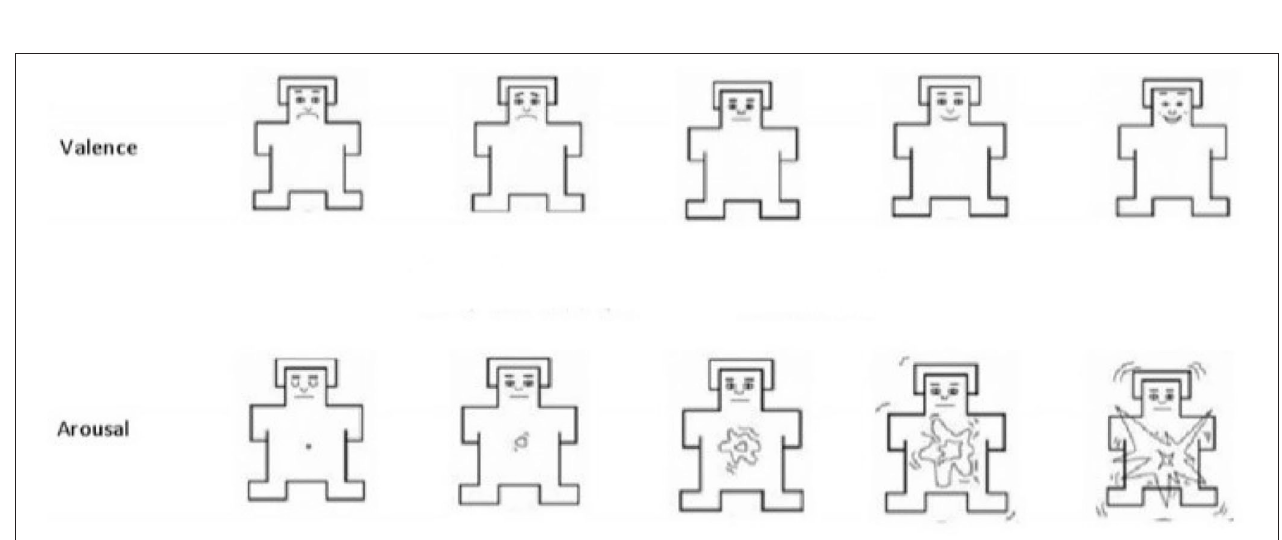
FIGURE 2 | Improved SAM